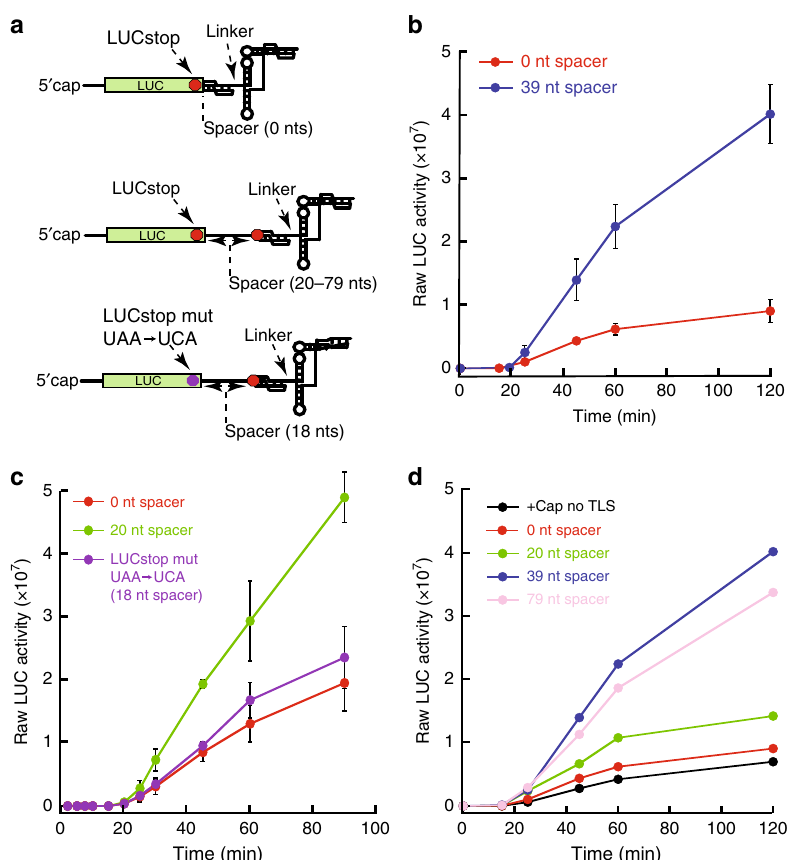
Fig. 2 TYMV 3 ′ -UTR context alters the rate of translation. a Luciferase (LUC) reporter design. Elements that were altered are indicated. The top reporter represents the 0 nt spacer, the middle reporter represents different spacer nucleotide lengths, and the bottom reporter represents the LUC stop codon mutant reporter (indicated by the magenta symbol). The red symbol represents the LUC stop codon and the stop codon that is inside the UPD. Reporters were capped unless indicated. b – d In vitro translation assays with: b two different spacers between the two stop codons; c two spacer lengths and the upstream stop codon mutated; d four spacer lengths with data showing the mean translation levels for n ≥ 3 replicates. Absolute differences in LUC activity between panels are due to different amounts of lysate used. Error bars represent one s.e.m. of n ≥ 3 replicates. Sequence details in Supplementary Fig.